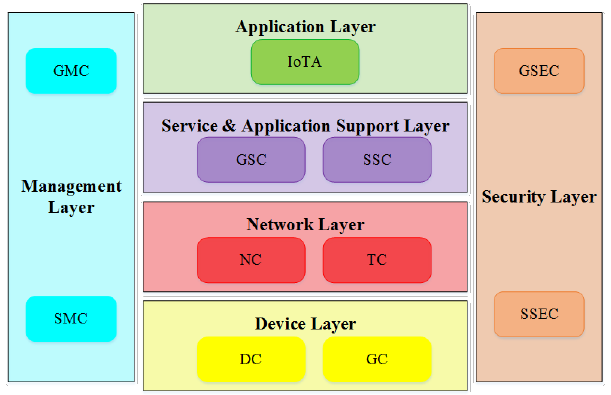
Figure 6. ITU-T Reference